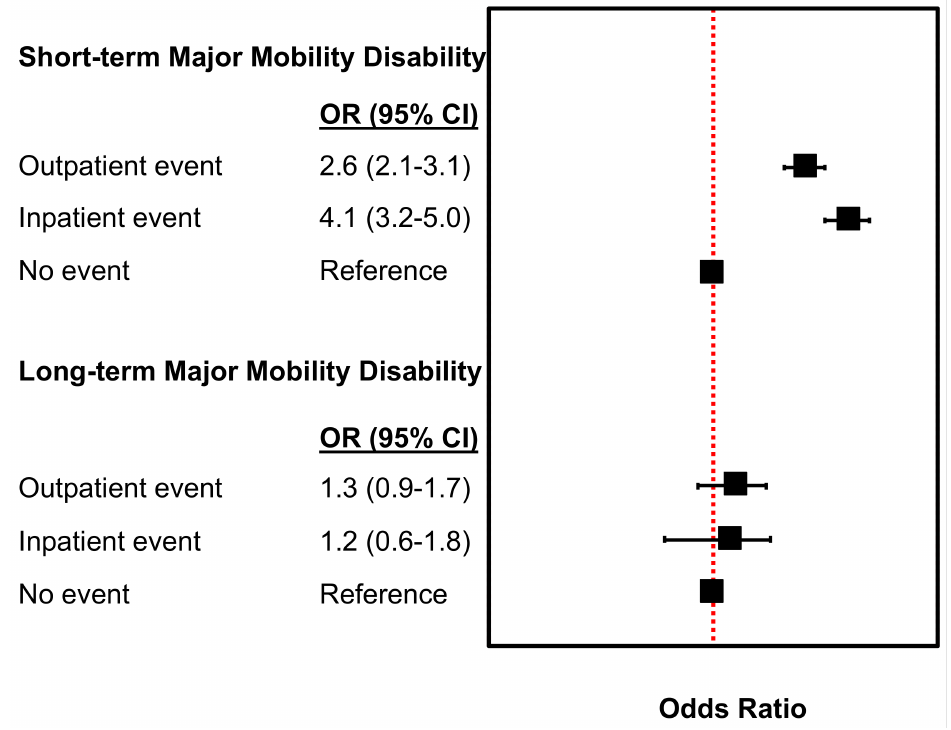
Figure 1. Adjusted odds ratios (OR) and 95% confidence intervals (95% CI) for the association be Table 1. or the null